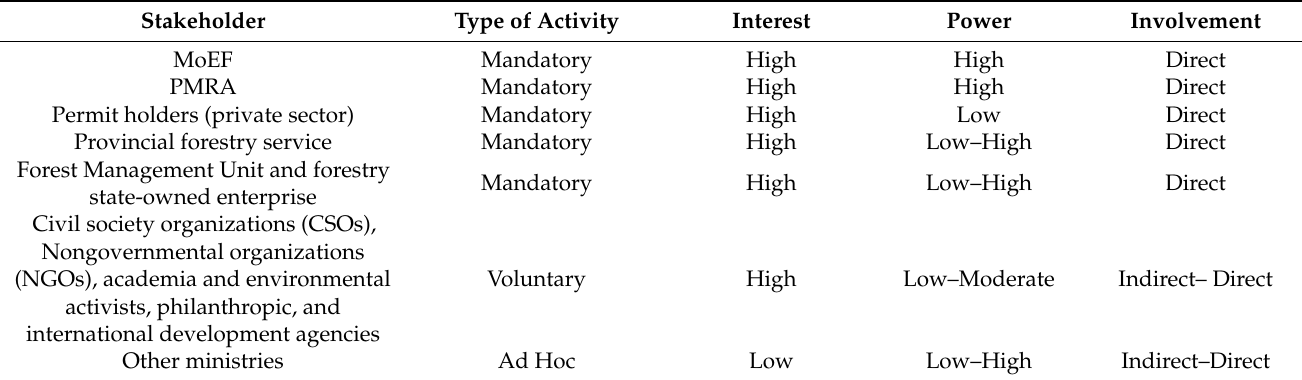
Table 2. Key stakeholders in Indonesian forest